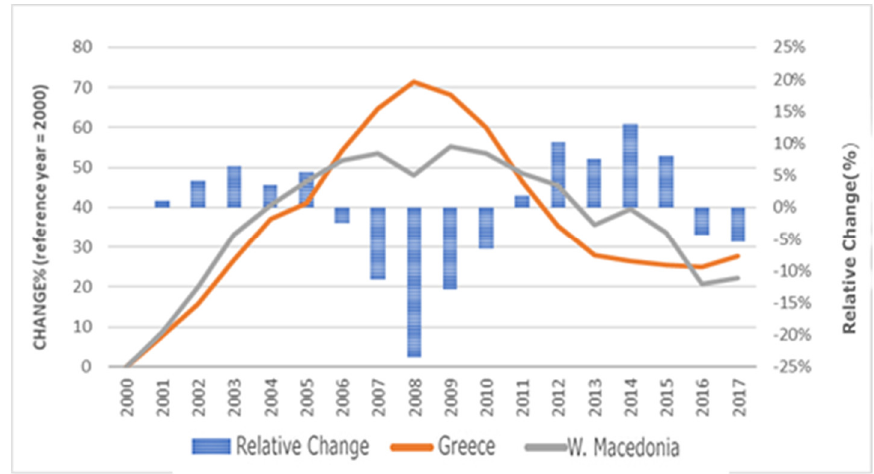
Figure 4. Annual change in Gross Value Added (GVA) in Greece and Western Macedonia (reference year 2000), Figure created by the authors using data from [11].